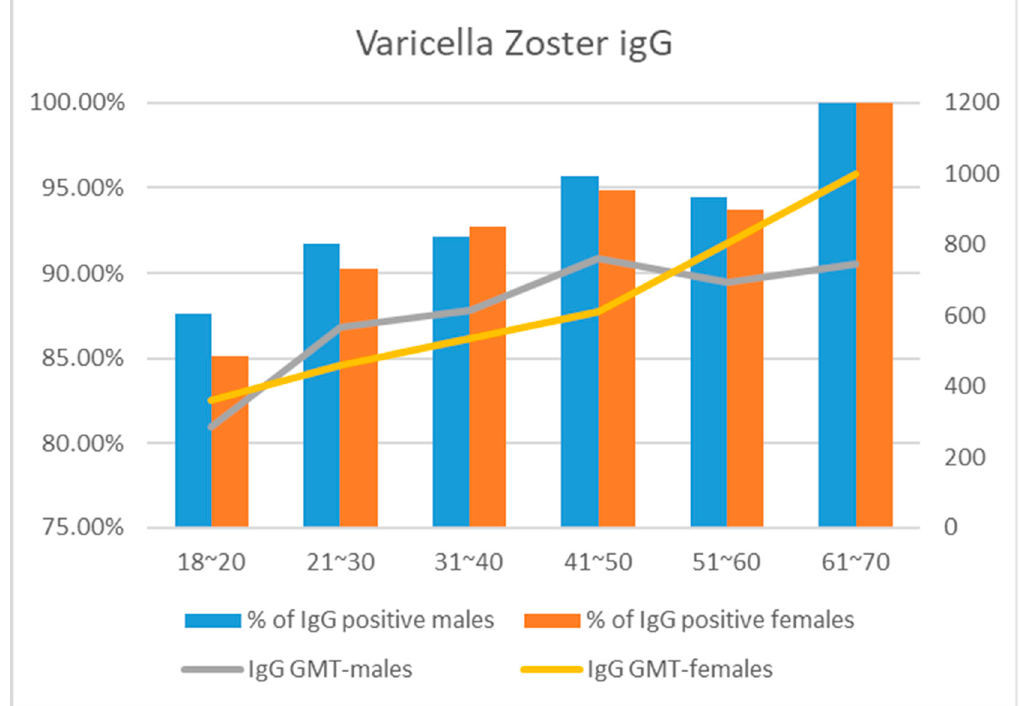
Figure 1. Proportion of varicella zoster immunoglobulin G (IgG)-positive subjects and varicella zoster IgG geometric mean titer (GMT), by age group and gender. Orange columns: % of varicella zoster IgG-positive females ( p < 0.001). Blue columns: % of varicella zoster IgG-positive males ( p = 0.310). Yellow line: Varicella zoster IgG GMT in females ( p < 0.001). Gray line: Varicella zoster IgG GMT in males ( p < 0.001) (Chi-squared test; linear regression).